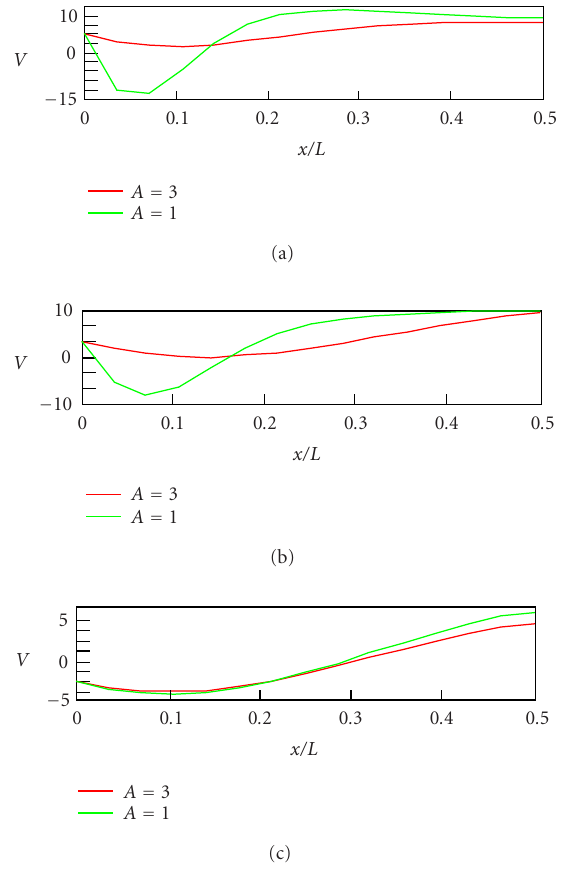
Figure 7: Velocity profiles at dimensionless radial, R = 0 . 5, in drums with two di ff erent aspect ratios under spin-down process from 5s/rev to zero: (a) t = 6 seconds, (b) t = 20 seconds, and (c) t = 40 seconds (Ohue et al.